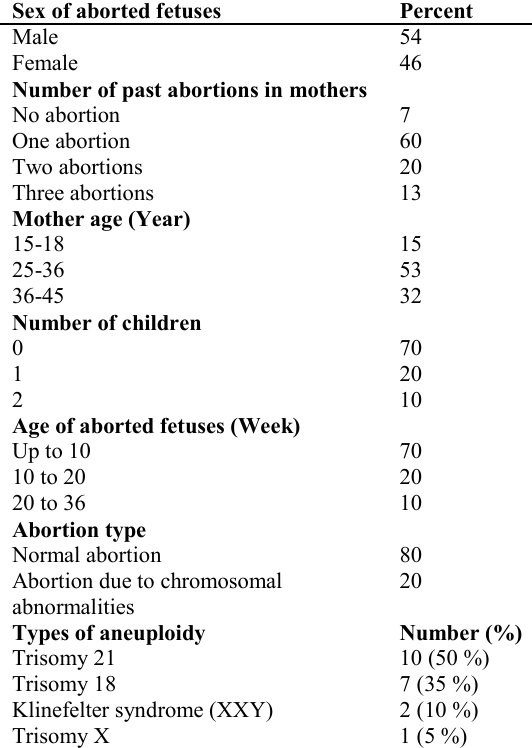
Table 2. Demographic data of mothers and aborted fetuses included in this